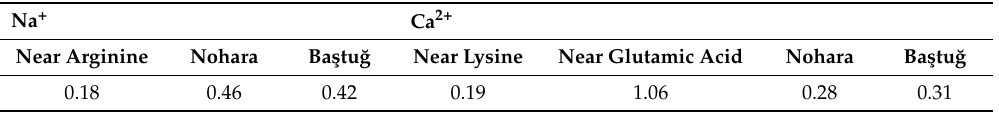
Table 6. Ratio of diffusion coefficients of cations to the diffusion coefficient of